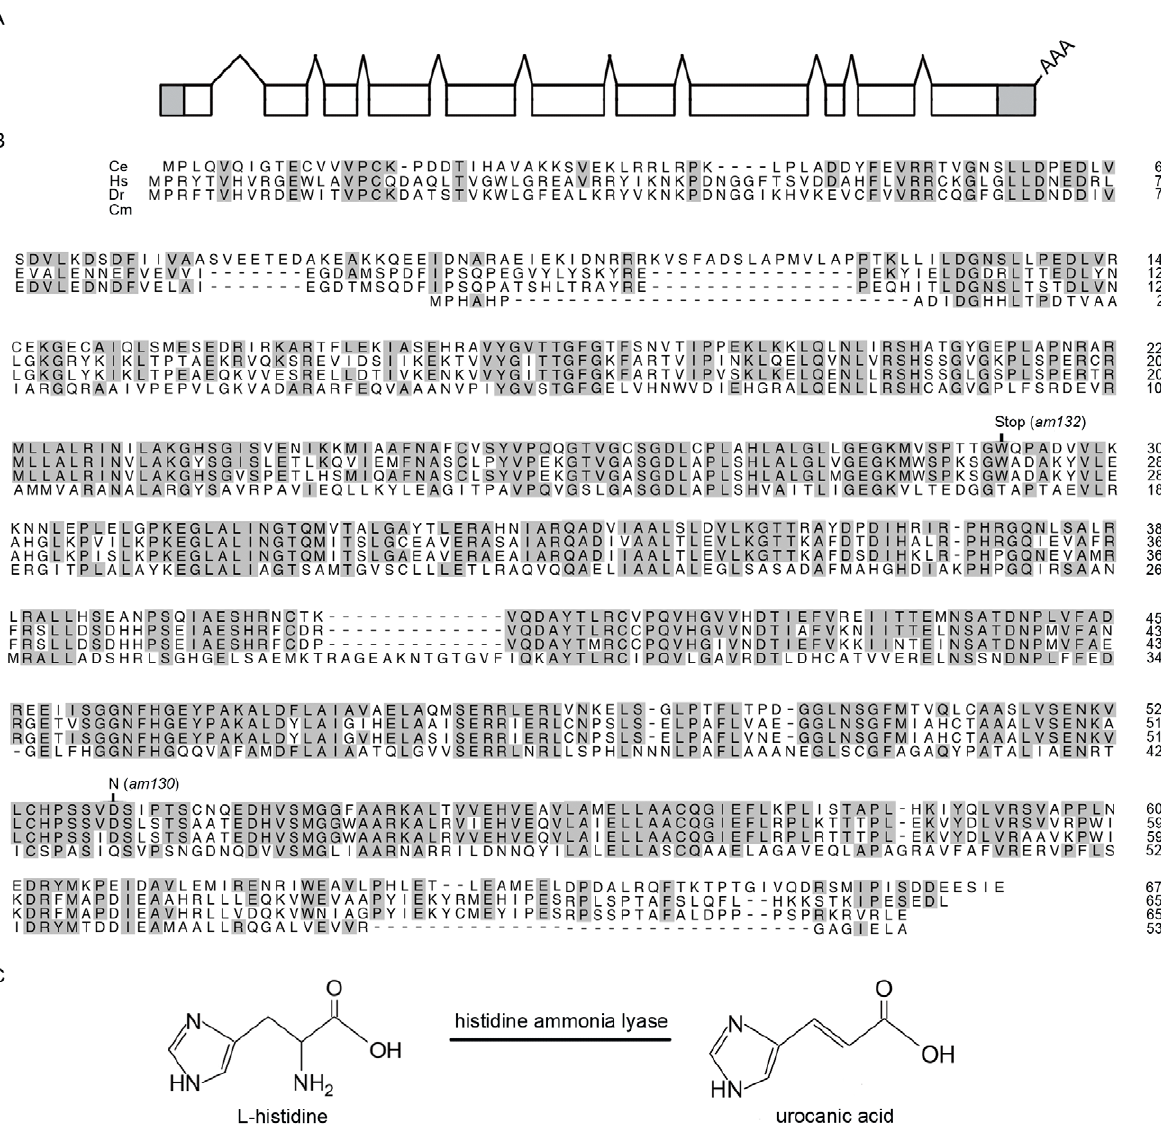
Figure 3. haly-1 encodes histidine ammonia lyase. (A) The haly-1 mRNA structure – boxes represent exons, shaded regions are untranslated, lines indicate introns, and AAA indicates the poly A addition site. (B) The predicted C. elegans HALY-1 protein is aligned with HAL proteins from Homo sapien, the zebra fish Danio rerio and the bacteria Cupriavidus metallidurans . Shading indicates residues identical to C. elegans HALY-1. The locations of the haly-1(am132) nonsense mutation and haly-1(am130) missense mutation are shown. (C) Histidine ammonia lyase causes the reductive deamination of L-histidine to urocanic acid.